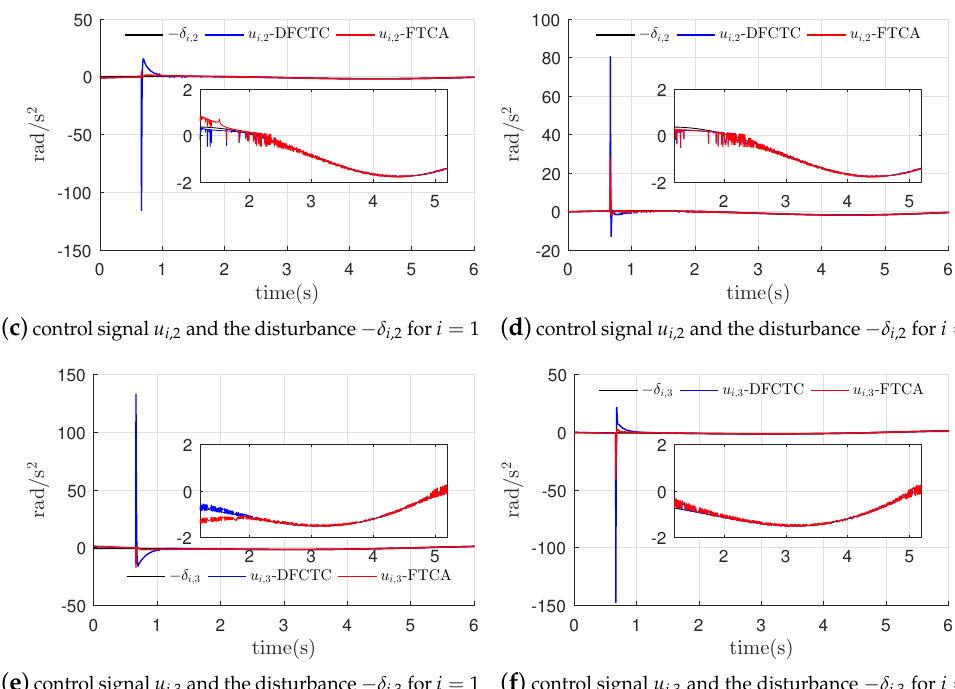
Figure 9. Control signals and disturbances for agents i =